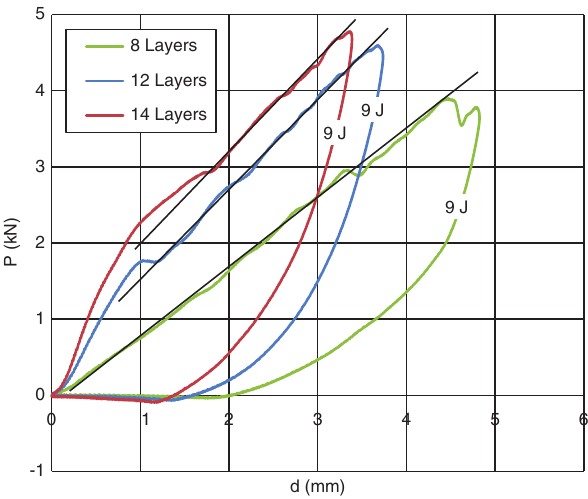
Figure 5 Impact load-deflection curves of the plates subjected to 9 J.